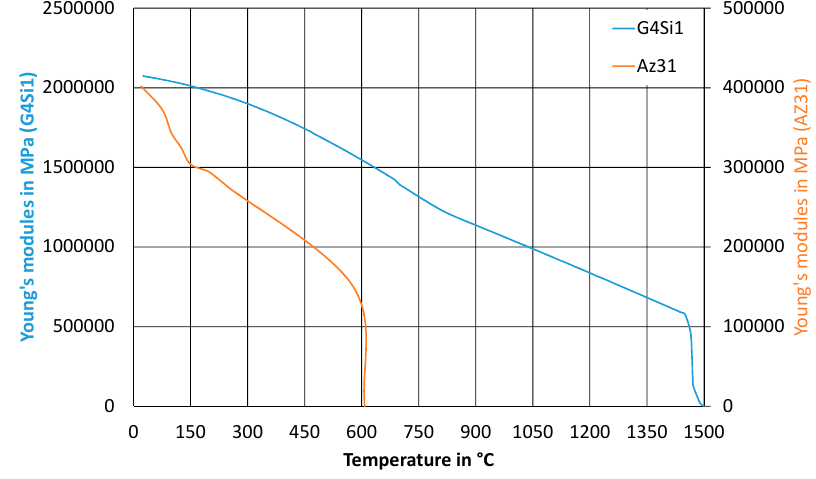
Figure 2. Young’s modules as function of temperature for G4Si1 (blue) and AZ31 (orange).